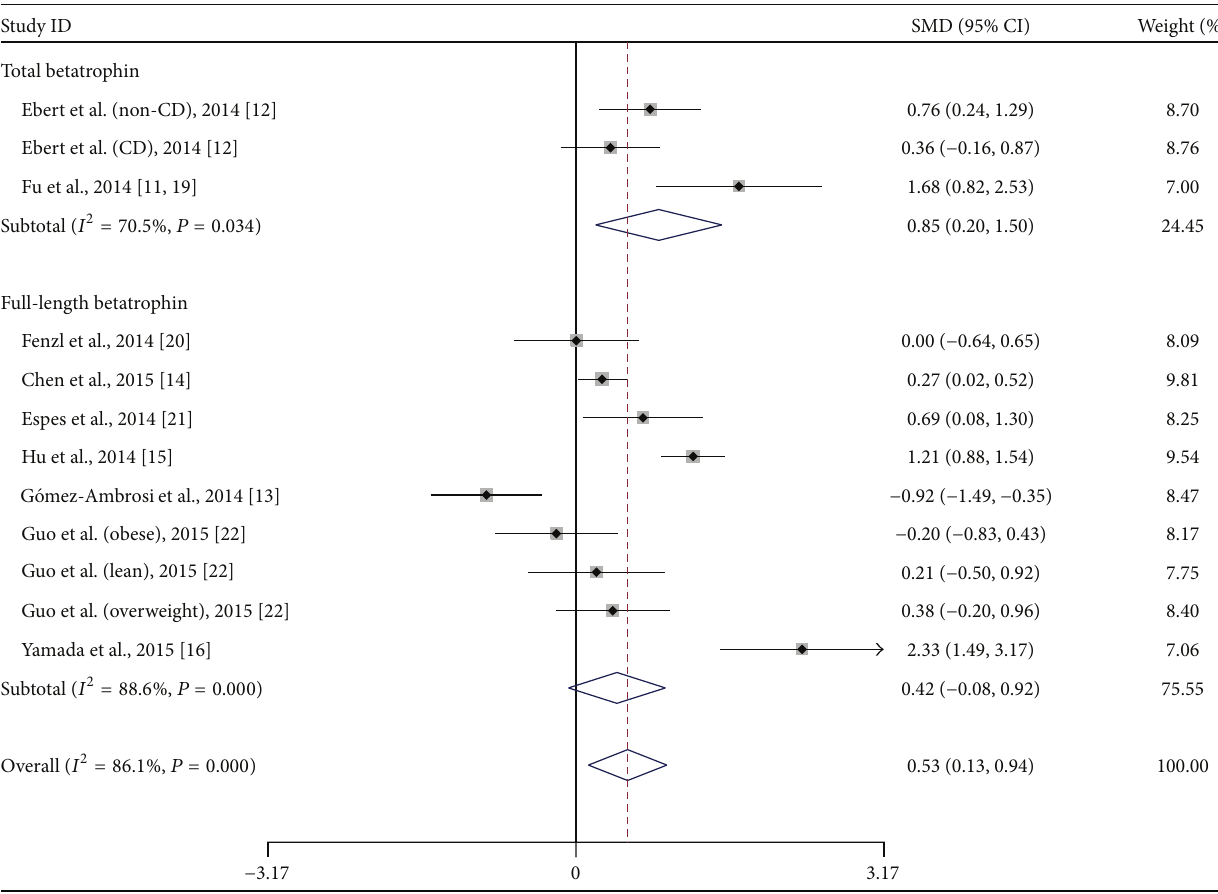
Figure 3: Subgroup analysis of circulating betatrophin level in T2DM or nondiabetic patients based on the ELISA kit selection. CD: chronic hemodialysis; CI: confidential interval; SMD: standard mean difference. Test for subgroup differences: 𝜒 2 = 1.0 ; df = 1 ; 𝑃 = 0.31 ; 𝐼 2 = 3.4